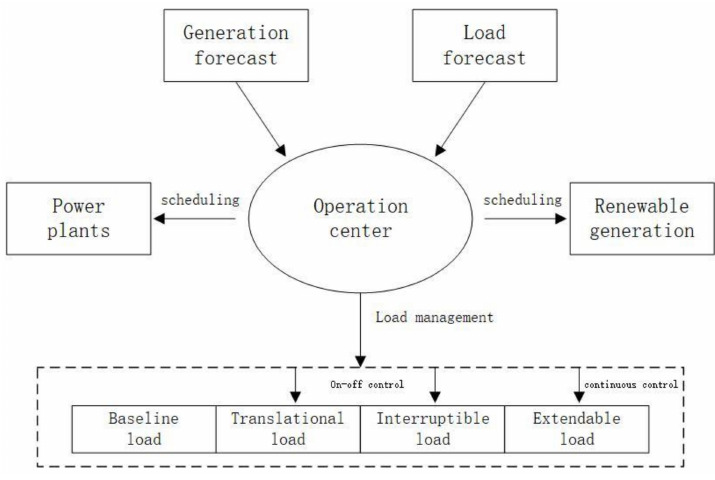
Figure 12. Framework of system operation and load